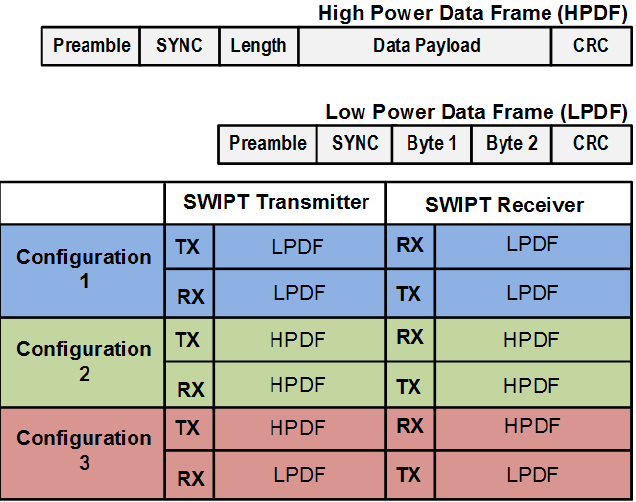
Figure 5. Frame structure for data packet communication (DPC) and its configuration in the SWIPT system.